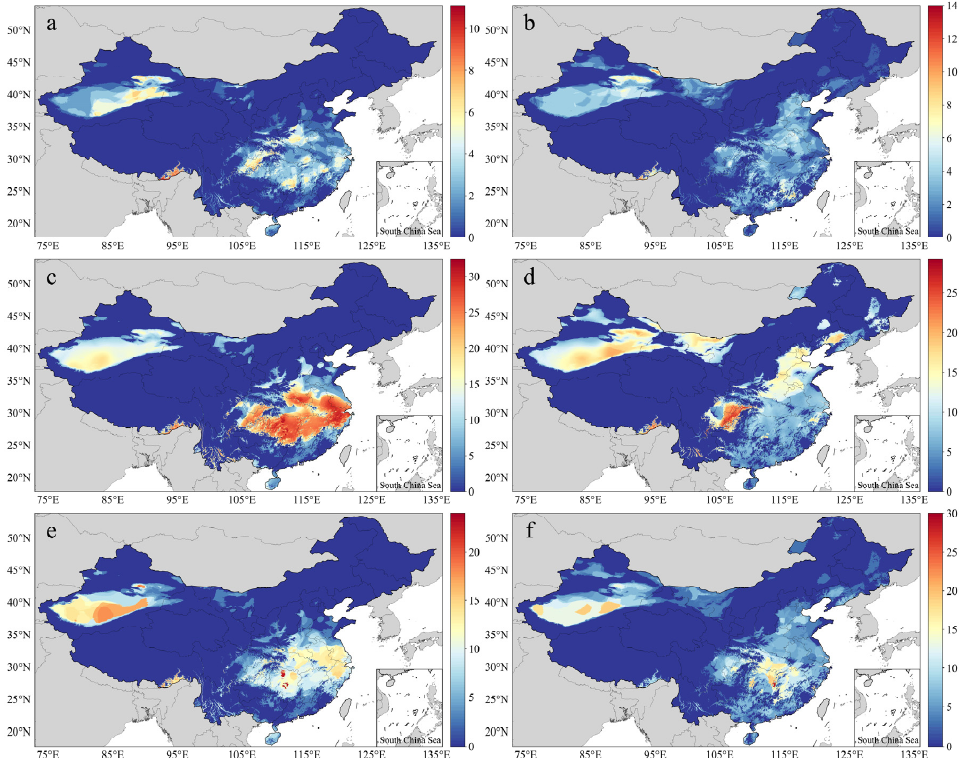
Figure 10. HWF, HWMHI, and HWMD values in 2013 ( a , c , e ) and 2018 ( b , d , f